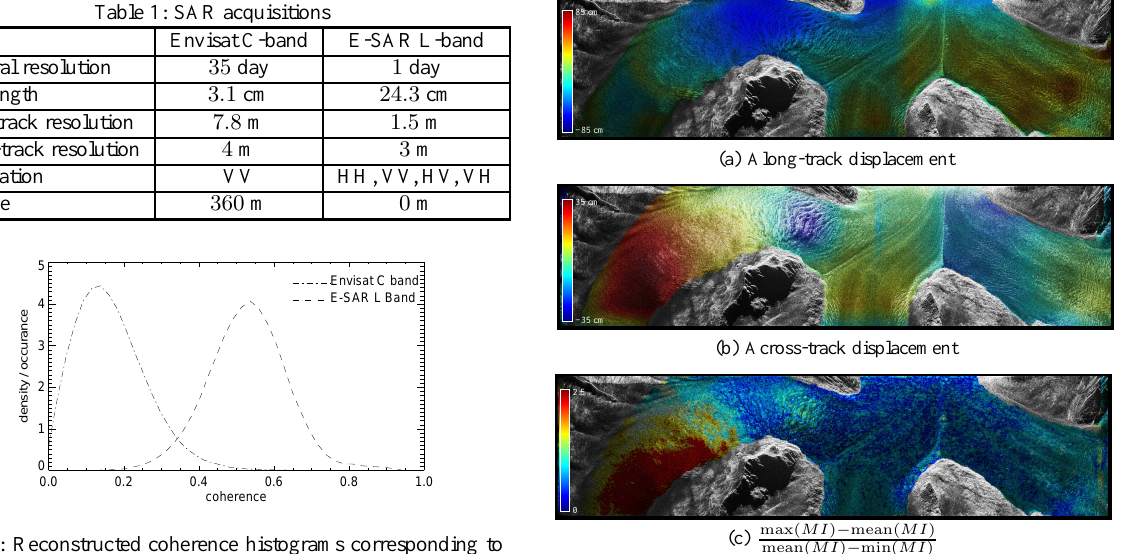
Figure 1: Reconstructed coherence histograms corresponding to the Aletsch glacier, after a 1 day and to Inyltshik glacier after 35 day time interval, using a coherence estimation window of 11 × 11 samples.